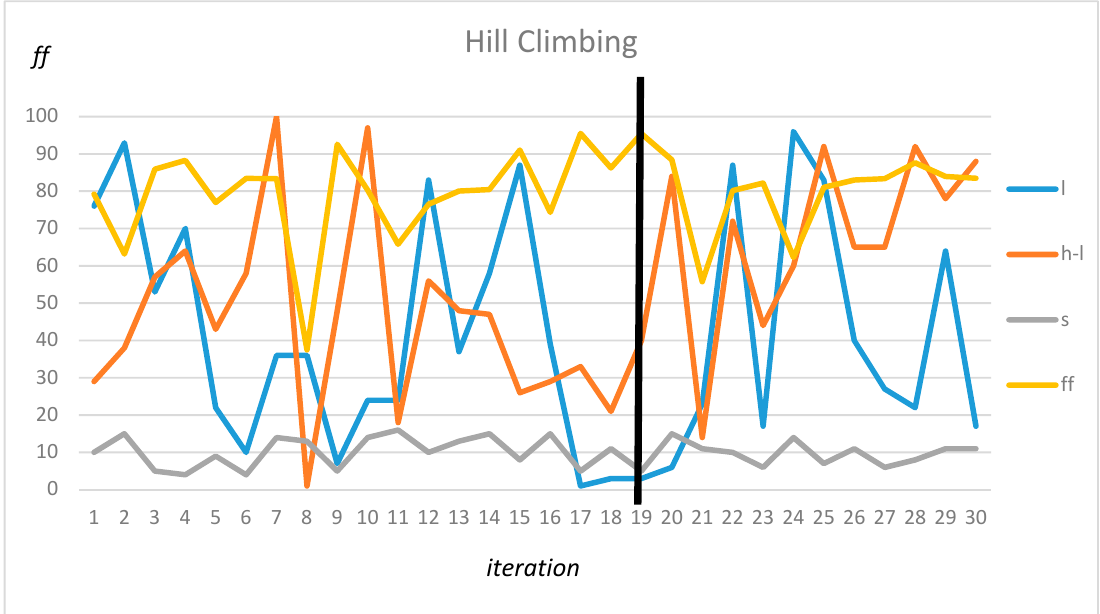
Figure 14. Hill climbing method optimization.